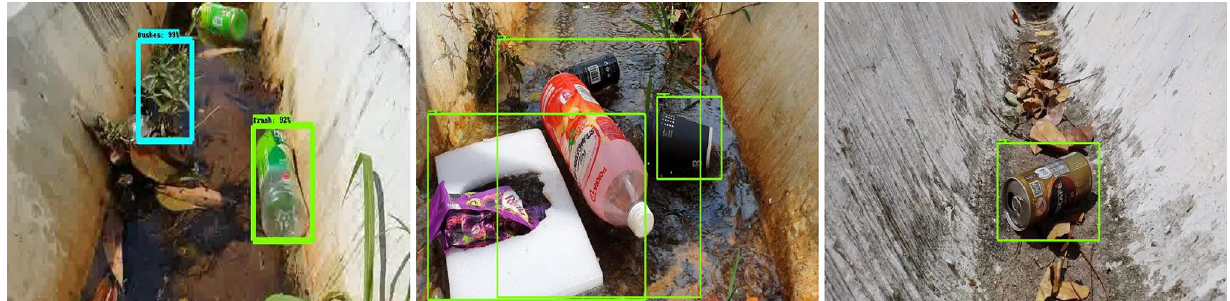
Figure 15. Trash detection on real time drain inspection field test (day).